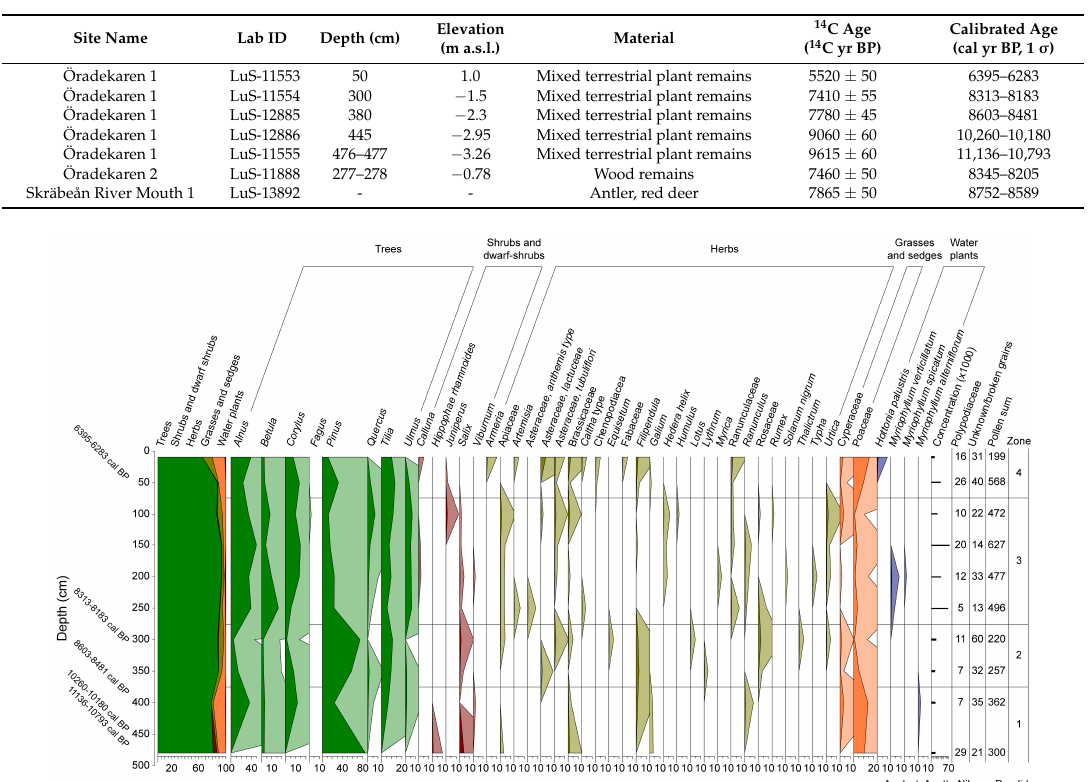
Table 2. Sample details and calibration results of 14 C dates included in this study. The 14 C ages were calibrated using the OxCal 4.2.4 software [89] and the INTCAL13 calibration data set [88]. The antler from Skräbeån River Mouth was found when dredging and therefore lacks elevation information.